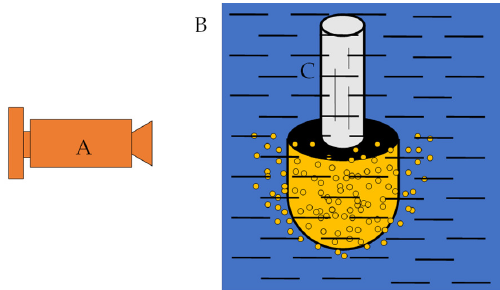
Figure 3. Sketch of the position of the camera. A—high-speed camera; B—beaker wall; C—porous nozzle.